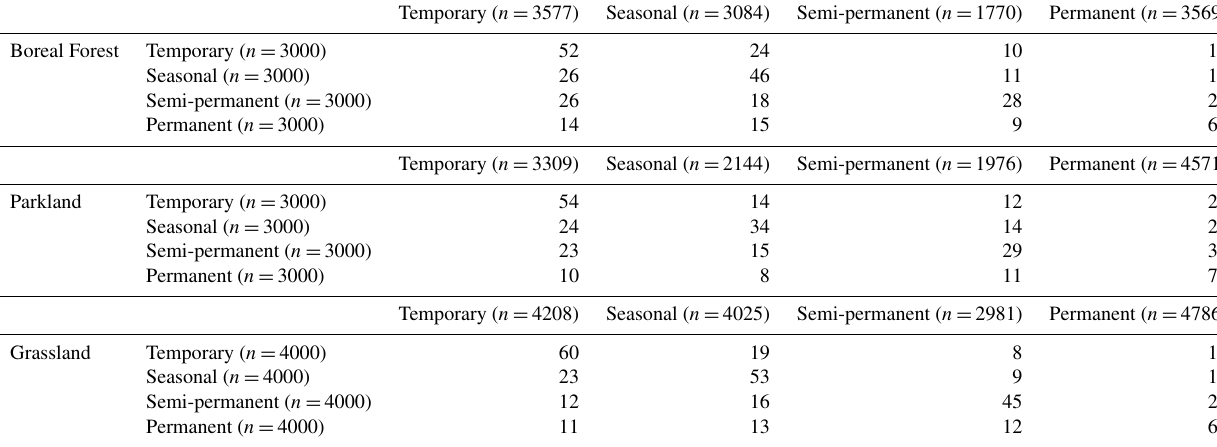
Table D2. Breakdown of misclassification error by permanence class. Data reflect the percent of wetlands classified as a given permanence class by the inventory (row) that the model classified as each permanence class (column). In general, models fared better at classifying temporary and permanent wetlands and exhibited more misclassification errors in classifying wetlands that the inventory categorized as seasonal or semi-permanent. Semi-permanent wetlands, in particular, tended to be under-predicted by the models. Temporary ( n = 3577) Seasonal ( n = 3084) Semi-permanent ( n = 1770) Permanent ( n = 3569) Boreal